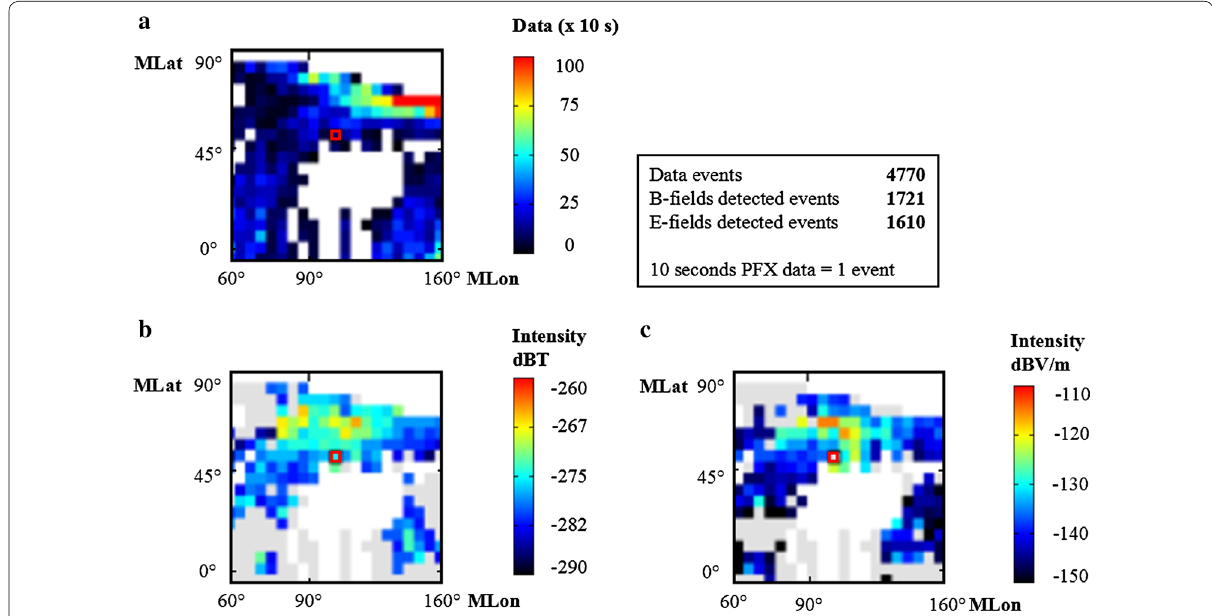
Fig. 2 a Duration of data processed in the magnetic and electric field below altitude 640 km. b Omega signal propagation for the Norway station in the magnetic field, and c the electric field. The rectangle indicates the location of the Norway station at latitude 55.96° N and longitude 100.72°